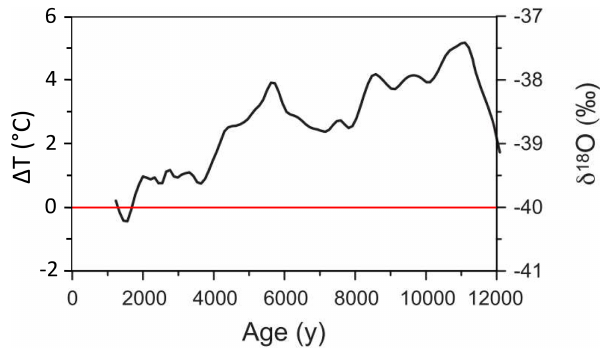
Figure 2. Stable isotope ( δ 18 O) record from Taylor Dome ice core and paleotemperature reconstruction. A reference line for 0 (cid:49)T ( ◦ C) is shown in red, representing deviation from modern tempera- tures. Modified from Monnin et al.